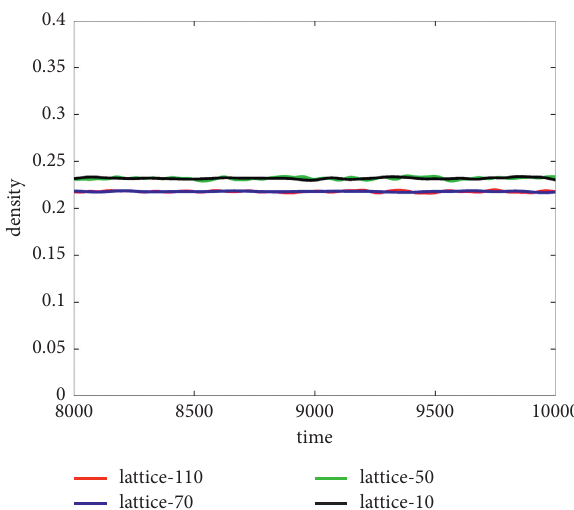
Figure 13: Density evolution